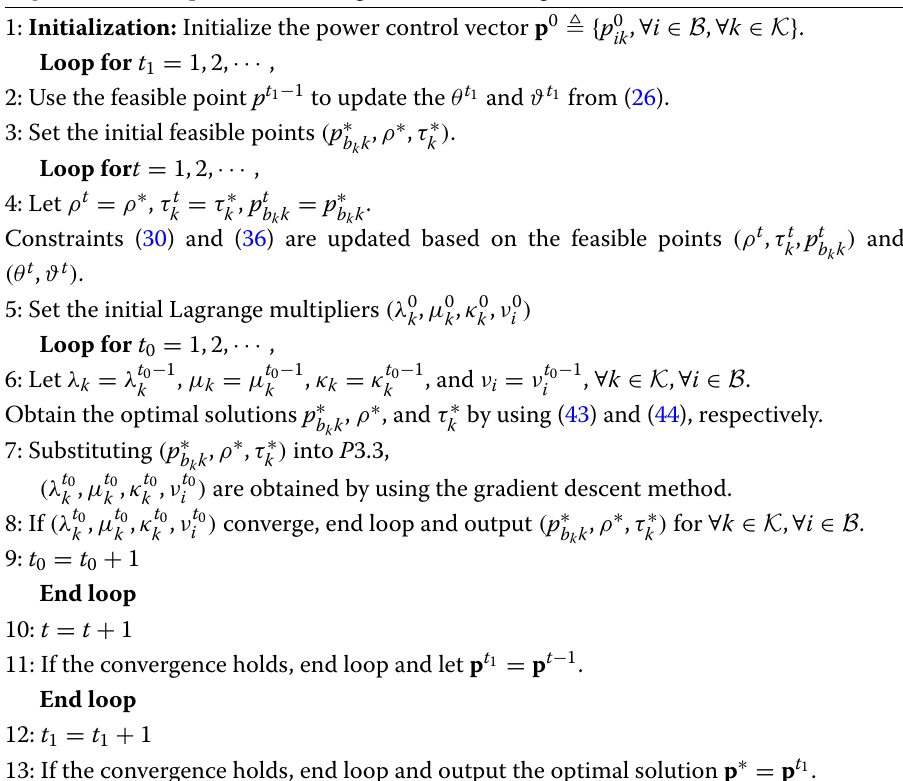
Algorithm 2 The power control algorithm for solving P 3.